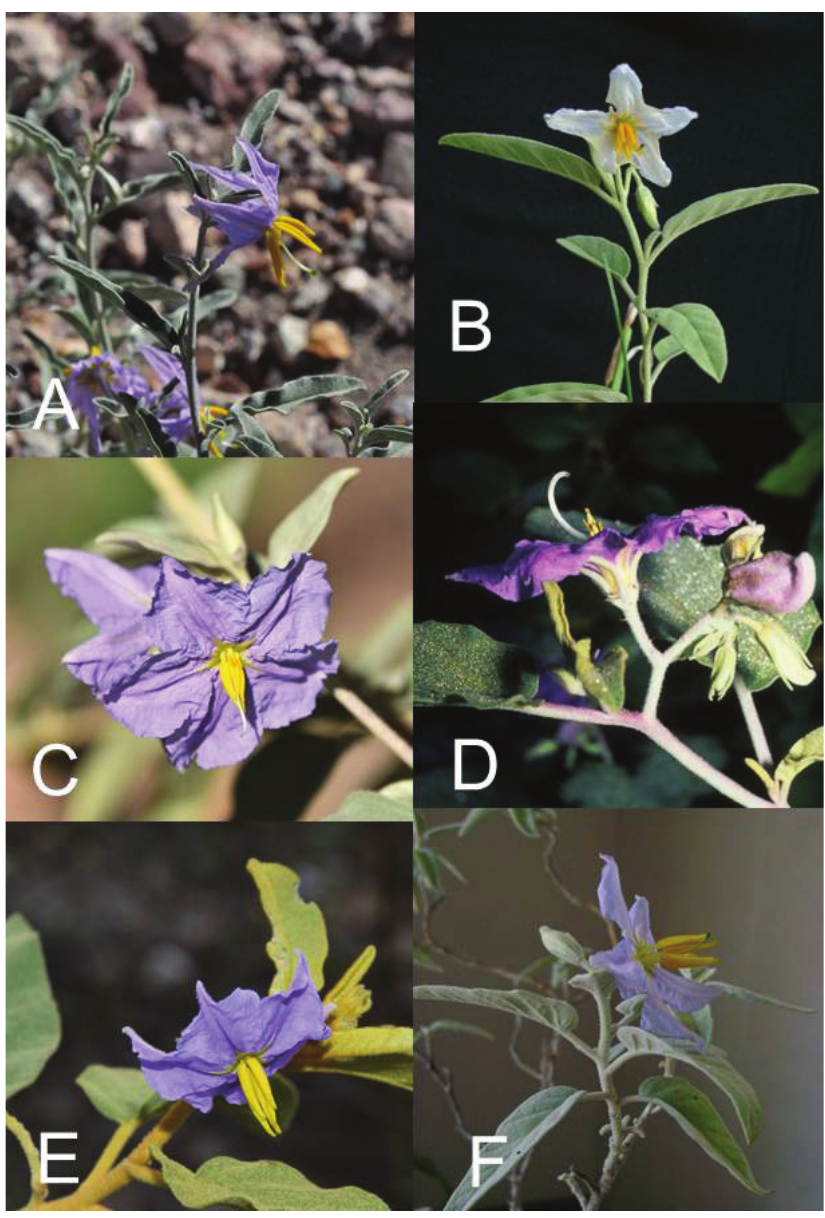
Figure 2. Flowers of members of the Elaeagnifolium clade. A Solanum elaeagnifolium , with divergent anthers of approximately equal size and shape (Argentina, Mendoza, Knapp et al. 10470 ) B Solanum hom- alospermum (Argentina, Catamarca, Chiarini et al. 505 ) C Solanum hindsianum (cultivated in Arizona) D Solanum houstonii , hermaphroditic flower and strongly curved buds (Mexico, Yucatán, Peña-Chocarro et al. 407 ) E Solanum houstonii , staminate flower (Mexico, Querétaro, Ochoterena et al. 976 ) F Solanum mortonii (cultivated in Córdoba; from Barboza et al. 644 ). Photographs A, D, E by S. Knapp; B, F by F. Chiarini; C by Eugene